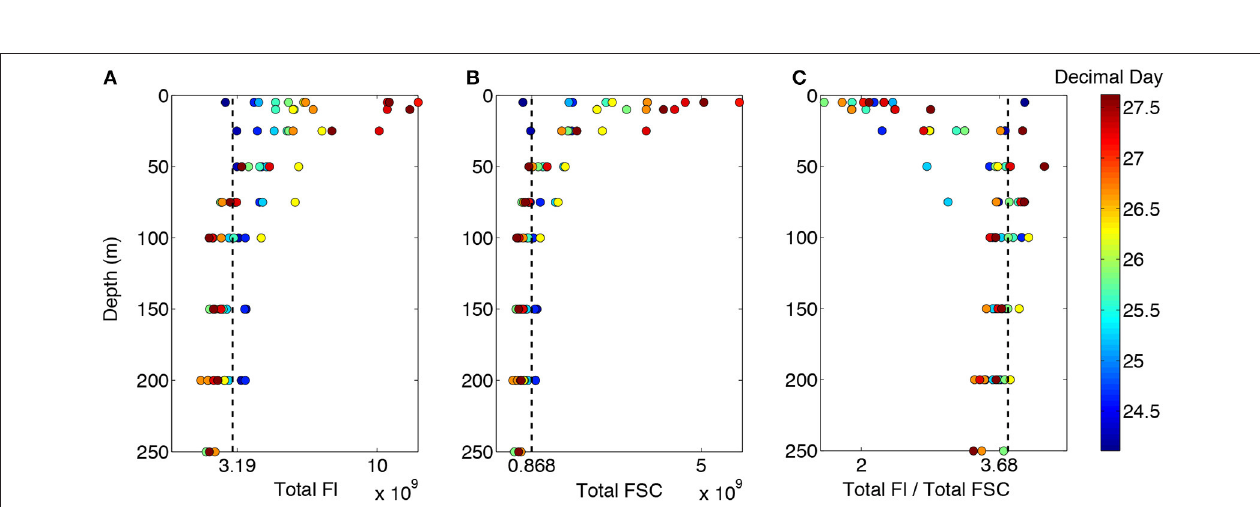
FIGURE 3 | Depth profiles of (A) total fluorescence, (B) total forward scatter, and (C) fluorescence to forward scatter ratio. Color bar represents time of sampling and dashed lines are mean values for the depths sampled within the first few hours of arrival on station.